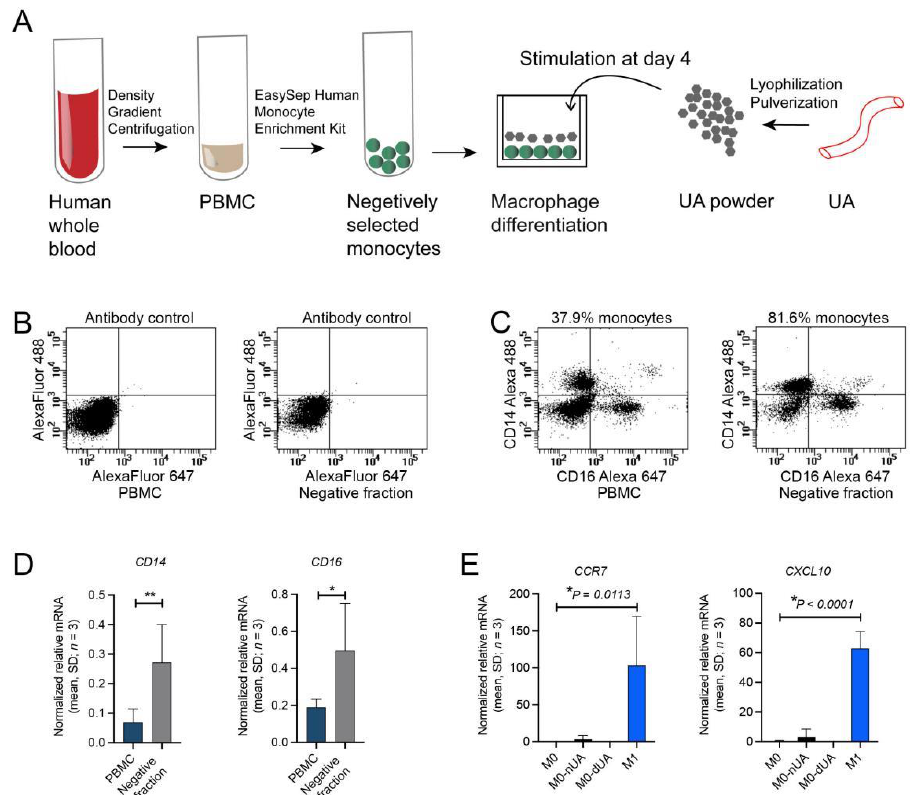
Figure 7. Ex vivo human pro-inflammatory profile of lyophilised human dUA powder. ( A ) Flow chart of human macrophage polarization upon lyophilised and powdered dUA stimulation. Peripheral blood mononuclear cells (PBMCs) were isolated from human whole blood ( n = 3) after density gradient centrifugation. Human monocytes were isolated in the negative selected fraction and differentiated into M0 macrophages. At day 4, cells were stimulated with either lyophilised/powdered dUA or nUA or LPS/IFN γ for M1 stimulation ( n = 3). ( B , C ) Representative flow cytometry of PBMCs and negative selected monocytes using ( B ) antibody controls or ( C ) CD14 and CD16 antibodies confirming monocyte enrichment. ( D ) Relative quantitative RT-PCR of PBMCs and negative selected monocytes for CD14 and CD16 mRNA expression further supporting monocyte enrichment. Ratio paired t-test (two-tailed) is used for statistical analysis. * p ≤ 0.05, ** p ≤ 0.01. ( E ) Relative quantitative RT-PCR of the pro-inflammatory M1 markers (CCR7 and CXCL10, see also Supplementary Figure S4) in M0 macrophages, nUA or dUA powder stimulated M0 macrophages (M0-nUA and M0-dUA, respectively), and positive control group (M1) stimulated by LPS and IFN γ . Ordinary one-way ANOVA (post-test: two-stage step-up method of Benjamini, Krieger, and Yekutieli) is used for statistical analysis ( n = 3). All qRT-PCR data were normalised against multiple stably expressed endogenous controls according to the qbase+ platform (data not